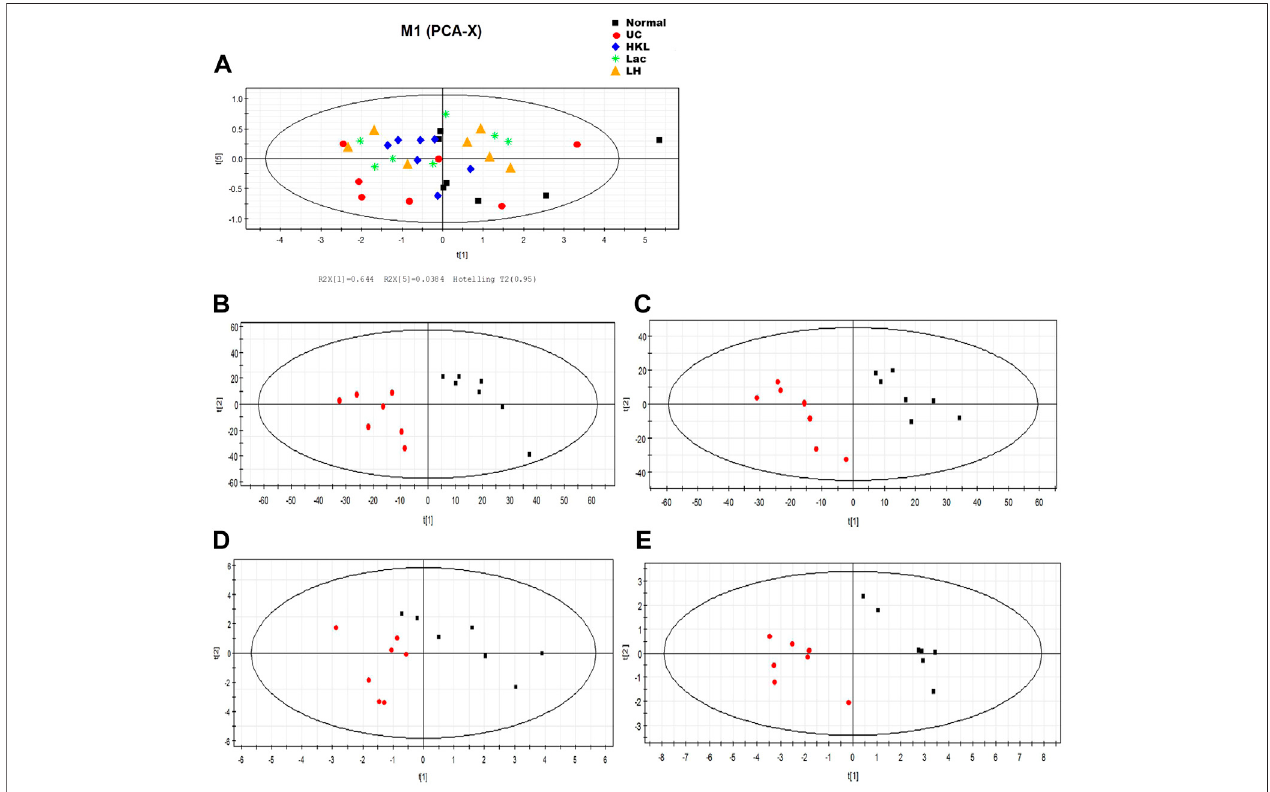
FIGURE9| LHtreatmenteffectonserummetabolism. (A) ScoresplotofPCAanalysisofallsamples;scoresplotofPLS-DAofUCvs.normalgroup (B) ,HKLgroup (C) , Lac group (D) , and LH group (E) . The red marks represent UC group samples ( n = 7).